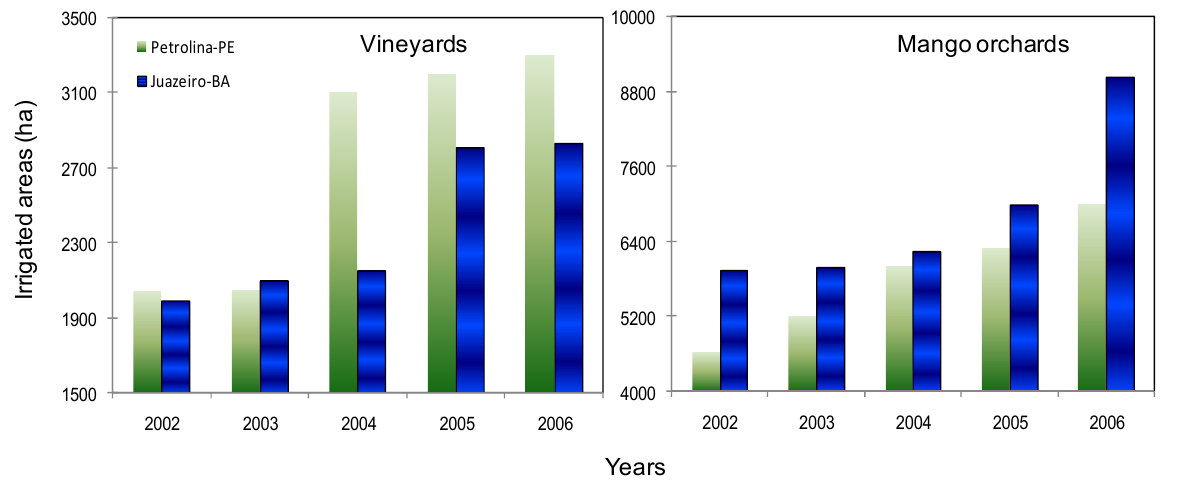
Figure 9. Evolution of cultivated areas with vineyards and mango orchards for the centers of development Petrolina-PE/Juazeiro-BA in the Low-Middle São Francisco river